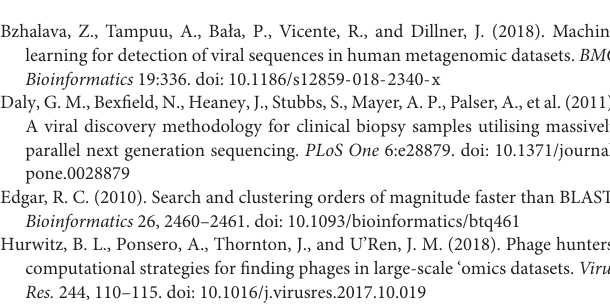
FIGURE S2 | Recall and precision of a classifier trained on Tara Oceans Metagenomes. FIGURE S3 | False positive rate of VirFinder models for eukaryotic and prokaryotic sequences. FILE S1 | Material and